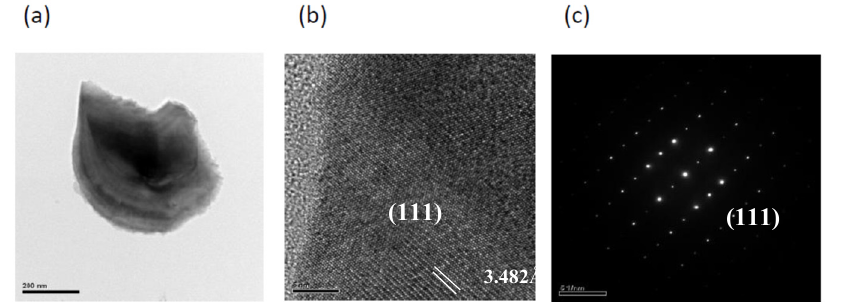
Figure 4. ( a ) TEM image; ( b ) HRTEM image; ( c ) SAED pattern of an agglomerated fine particles (showing it to be CaAlSiN 3 :Eu 2+ ) in a product synthesized with Ca:Al:Si:Si 3 N 4 :Eu 2 O 3 :NaN 3 :NH 4 Cl = 1.0:0.8:0.25:0.25:0.02:3.5:0.6.